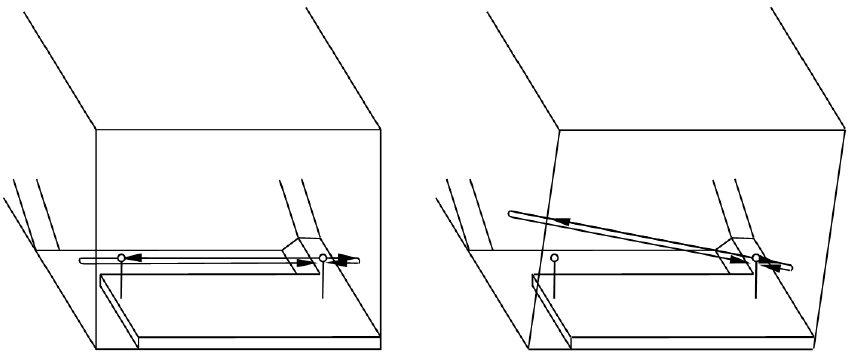
Figure 9. Shifting the zone of flutter echo formation ( left ) above the level of the performers’ heads by deviating the side walls from the vertical ( right ).